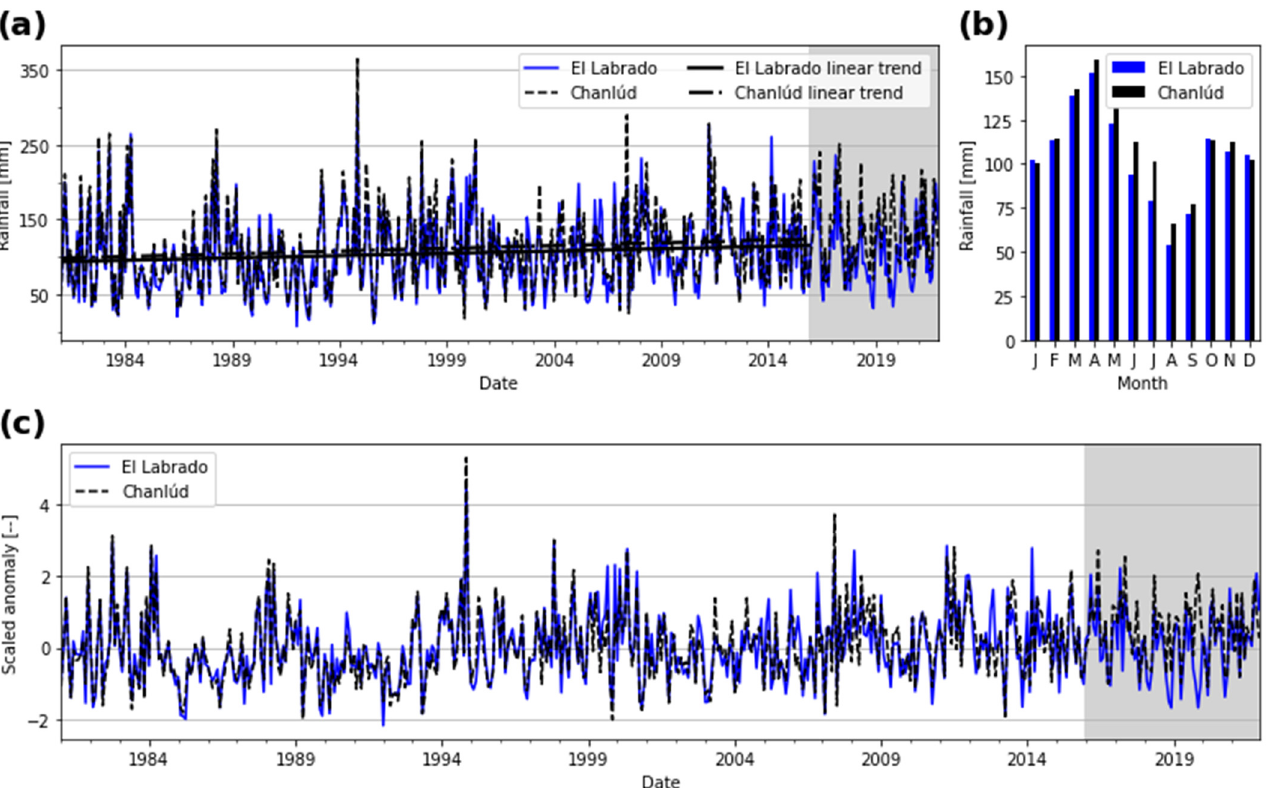
Figure 2. Rainfall in the study stations: ( a ) observations from 1981 to 2021, linear trends in the period 1981–2015 and the testing period 2016–2021 with the gray background; ( b ) seasonality in the period 1981–2015; ( c ) scaled anomalies based on the seasonality shown in ( b ).